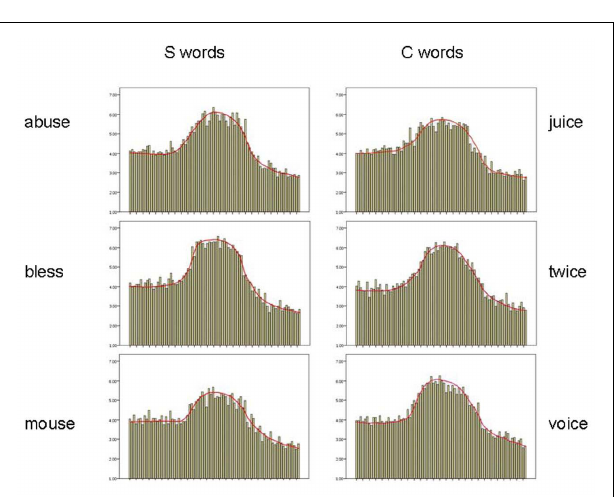
FIGURE 3 | Real English words rated by non-native listeners: mean rated goodness as /s/ on a 7-step scale (vertical axis) as a function of step on the 81-step continuum from /z/ at left through /s/ to / ∫ / at right (horizontal axis), separately for words spelled with S (solid line) and C (dashed line).